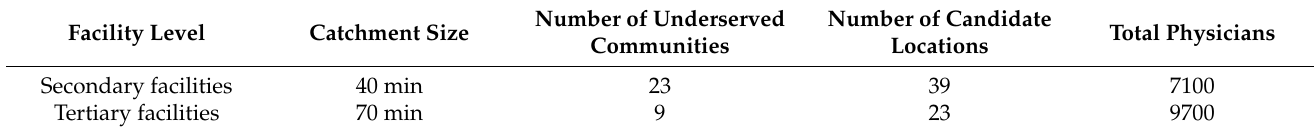
Table 2. Parameters at each